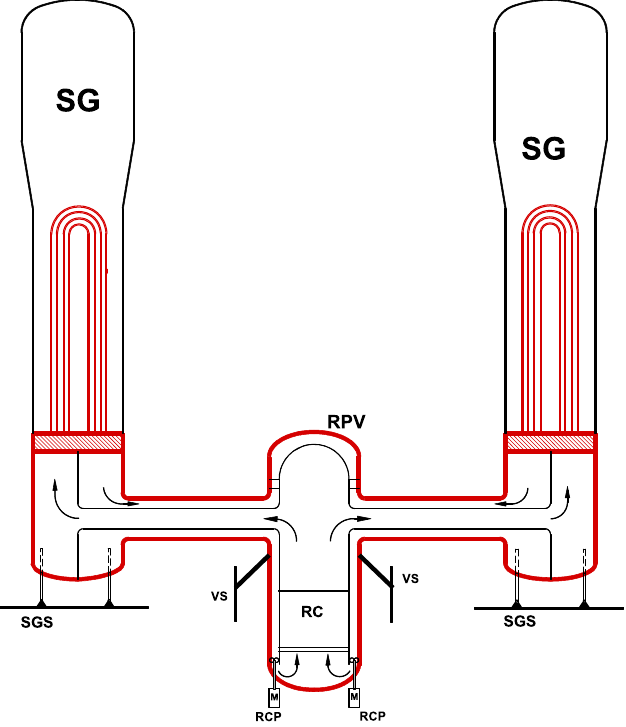
Fig. 1. A compact Reactor Coolant System (RCS). With a “ self- pressurization ” concept there is no pressurizer, the reactor core exit fl ow is saturated water with minimal steam quality (less than 1%), RCS design pressure is reduced to ∼ 125 bar, and RCS hot leg is at 110 bar, saturation temperature 318 ° C. Variable speed Reactor Coolant Pumps (RCP) are mounted at the Reactor Pressure Vessel (RPV) bottom circumference. Trip of the RCP, together with negative moderator void coef fi cient, ensures rapid negative reactivity insertion due to voiding at core exit, assisted by a safety boration to hot and/or cold shutdown condition. There is no need for mechanical control rods. The items indicated in the fi gure are: RPV, reactor pressure vessel; SG, steam generator; RC, reactor core; VS, RPV support; RCP, reactor coolant pumps; SGS, SG